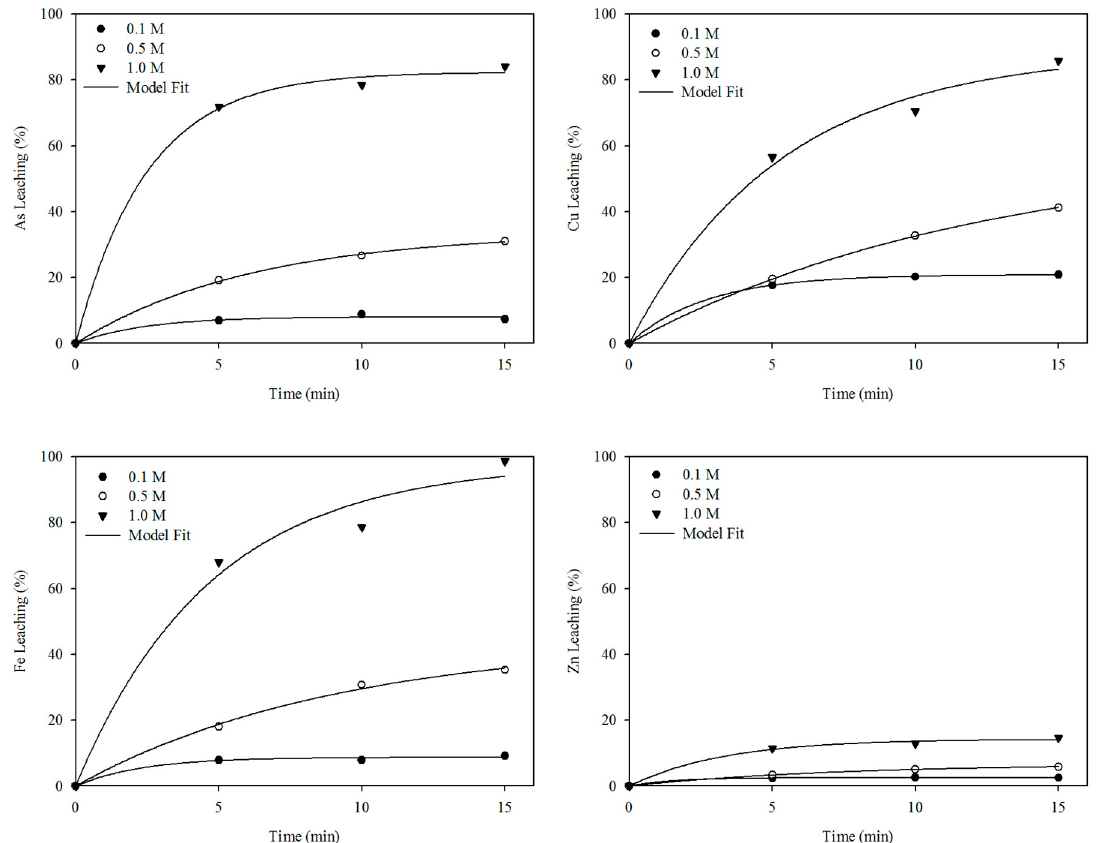
Figure 4. Effect of HNO 3 concentration on the leaching efficiencies of As, Cu, Zn, and Fe from the refractory gold concentrate. The leaching conditions were a reaction time of 15 min, reaction temperature of 80 °C, and HNO 3 concentration of 0.1, 0.5, or 1.0 M. According to Equation (2) in Table 2.